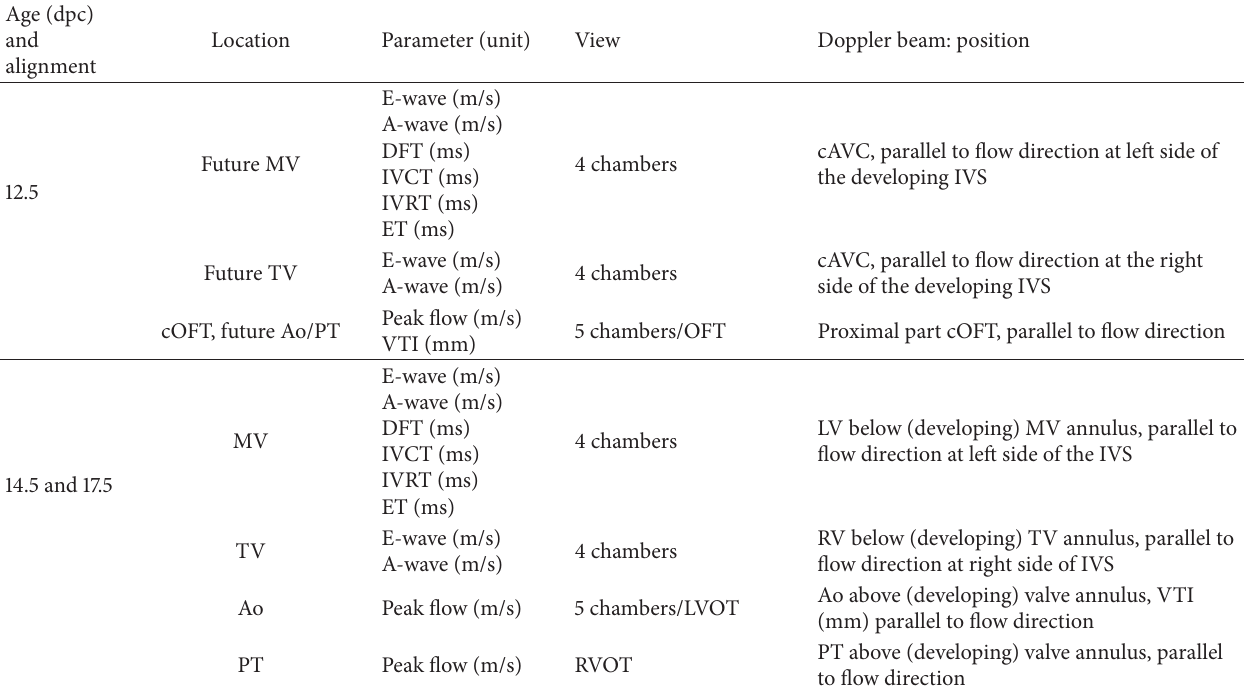
Table 1: The methods used for performing Doppler flow recordings per gestational age.